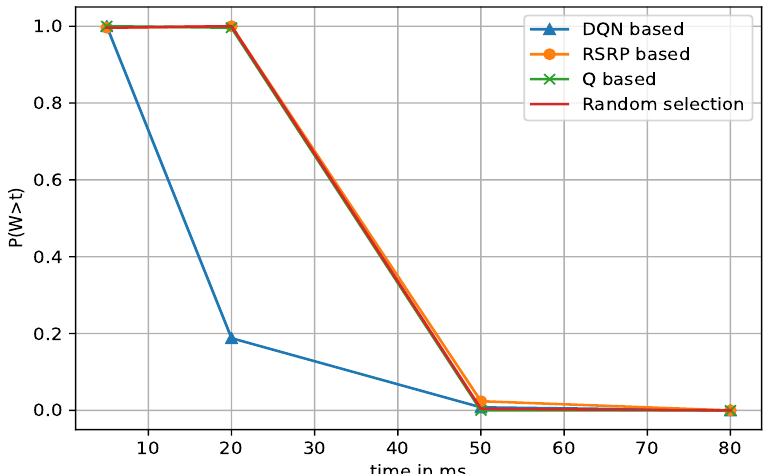
Figure 9. Comparison of waiting time distribution: DQN-based vs. others in random access net- work